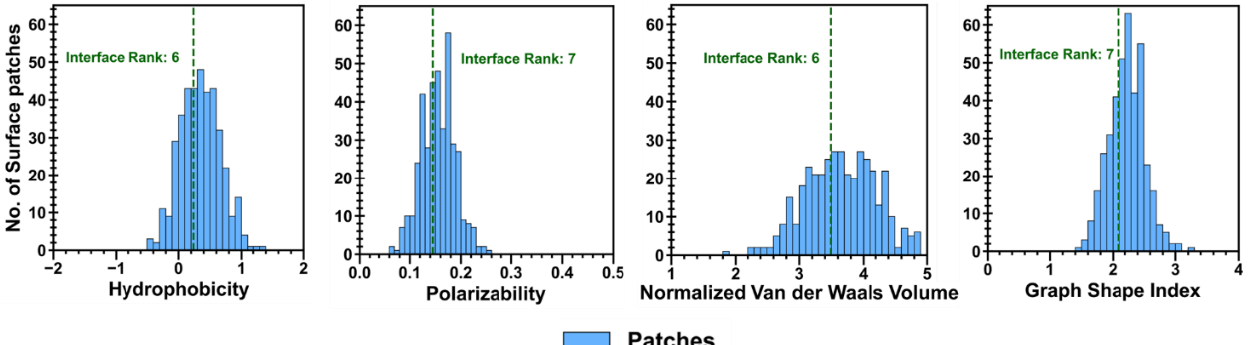
Figure A5. The distribution of the four physiochemical descriptors for ID2S surface patches (in blue) are plotted, in addition to the parameter ranking and descriptor values for a selected protein–polymer interface (green dashed line). For example, the hydrophobicity of the selected interface is ~0.22, meaning it is in the 60–70% range of the hydrophobicity patch distribution and therefore obtains a rank of 6. This comparison of the physiochemical descriptors between a sample interface and the generated surface patches was valuable in characterizing differences in protein–polymer binding.